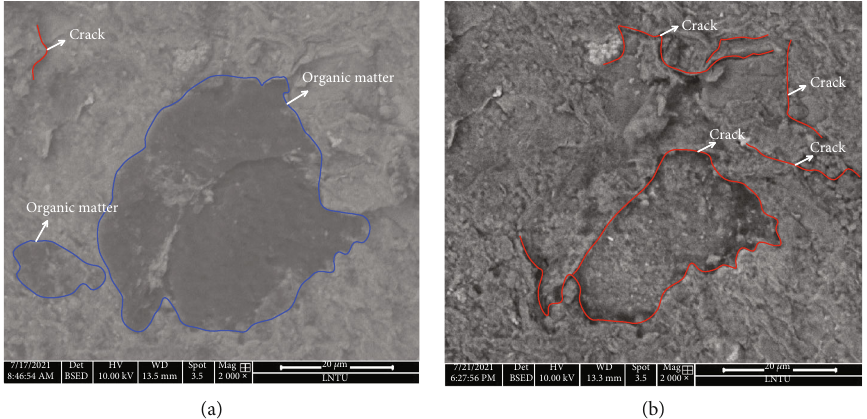
Figure 5: Backscattering image of oil shale at (a) 20 ° C and (b) 500 ° C at the same location.